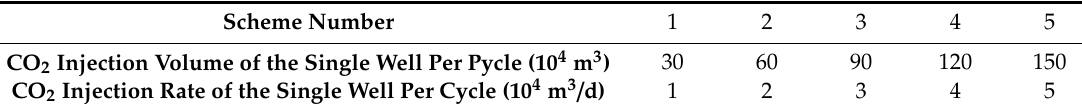
Table 8. CO 2 injection volume in di ff erent schemes.